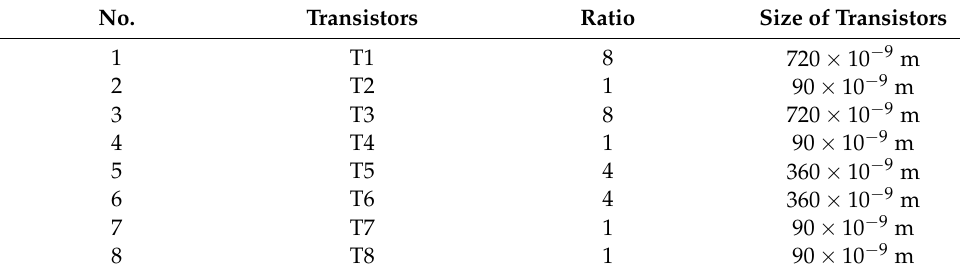
Table 1. Transistor size and ratio for bit cell configuration.